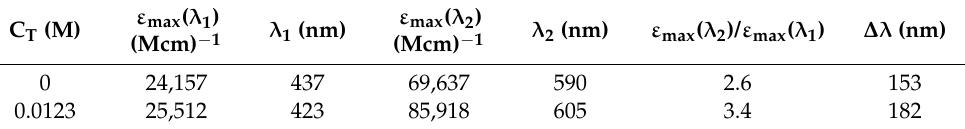
Figure 1. VIS spectra of BPB solutions at various pH values: ( a ) pH = 1.19 (red); 3.80 (orange); 3.99 (brown); 4.59 (magenta); 4.87 (violet); 6.59 (blue); ( b ) pH = 1.19 (red); 2.39 (orange); 2.60 (olive); and 4.47 (blue). The total concentration of the buffer solutions is constant and equal to ≈ 0.08 M. In ( b ) C T = 0.0123 M CTApTs. Table 1. Spectroscopic parameters, for BPB (concentration = 0.06 mM), with (C T = 0.0123 M) and without surfactant, ε max ( λ 1 ) and ε max ( λ 2 ) for the acidic and basic form, ε max ( λ 2 )/ ε max ( λ 1 ), and ∆λ(nm). C T (M)